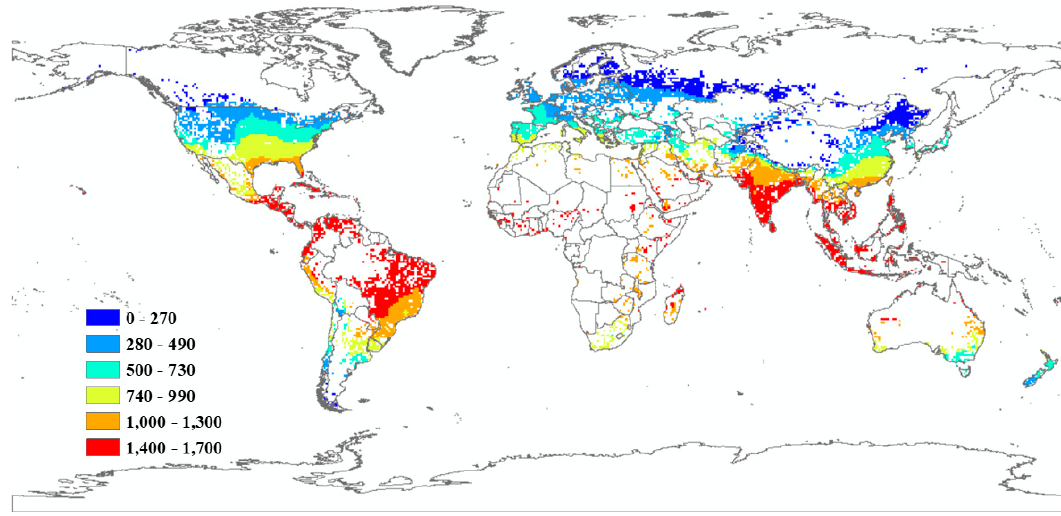
Figure 11. Net irrigation water requirement of NCAR model in 2050 (RCP4.5). The same irrigated area than in 1960 is used the same in figure 1.